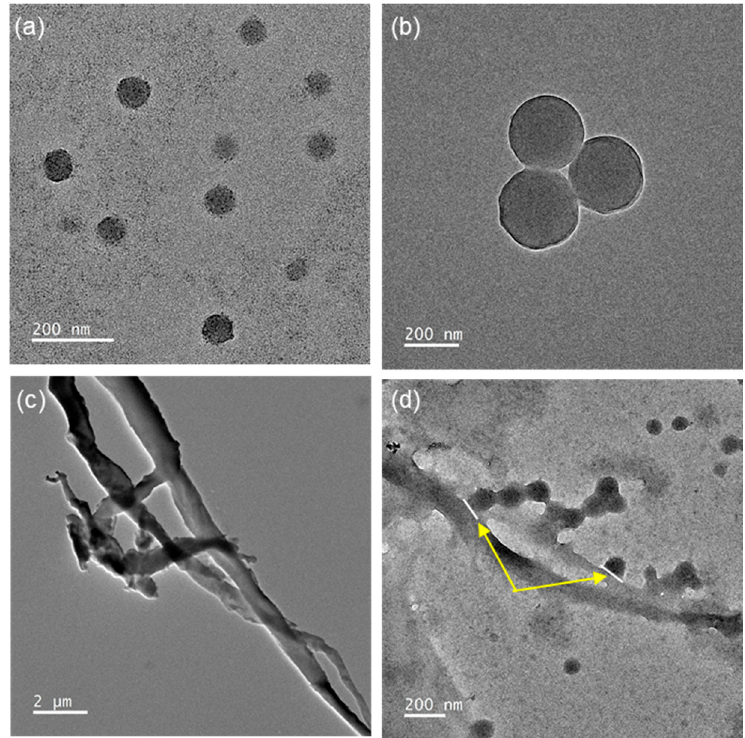
Figure 5. TEM images of the ( a ) TCR-1, ( b ) TCR-2, ( c ) only CF, and ( d ) TCR sample + CF nanocomposite reacting with hydrolysis CF.